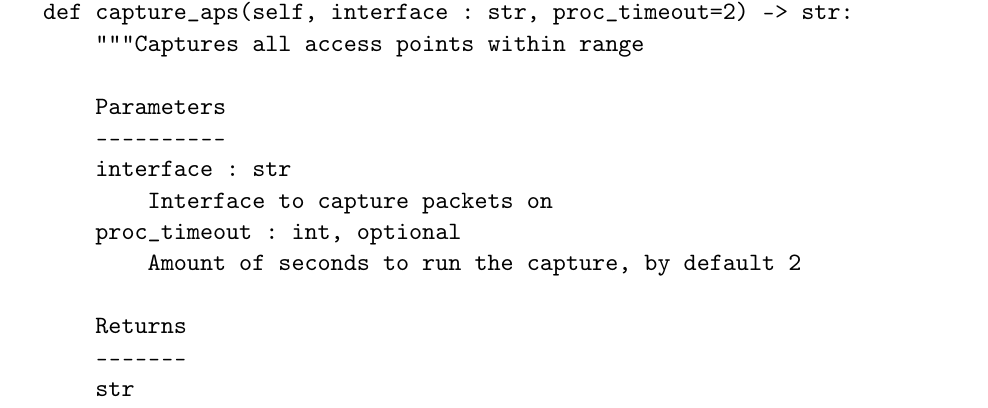
Algorithm 1: The function for capturing all APs within range.